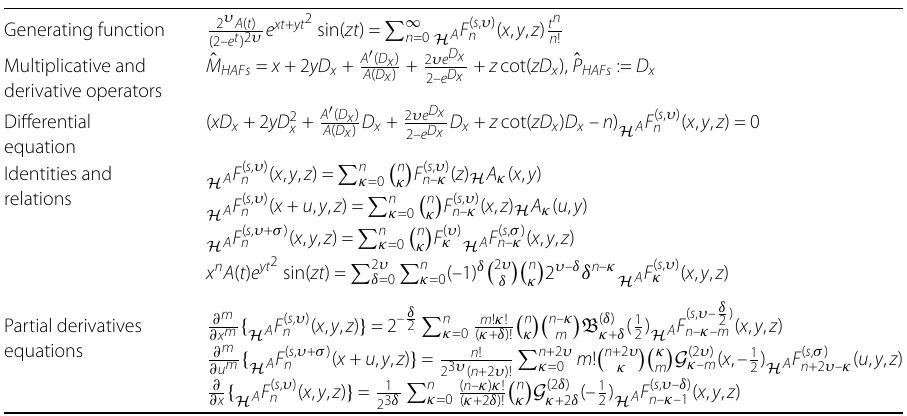
(cid:10) ∞ ( s , υ ) n ( x , y , z ) n =0 H A F